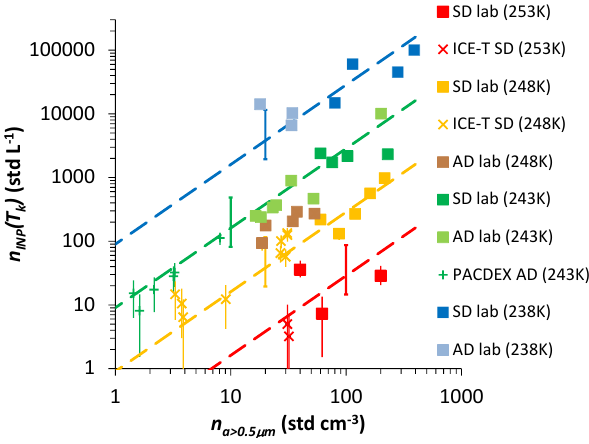
Figure 6. Prediction of Eq. 2 (cf = 1, α = 0, β = 1.25, γ = 0.46, and δ =− 11.6), plotted vs. raw field and laboratory data collected at 105% RH w (Fig. 5), with lines added around the 1 : 1 line (solid) to indicate standard error (short-dashed lines) and 95% confidence intervals (long-dashed